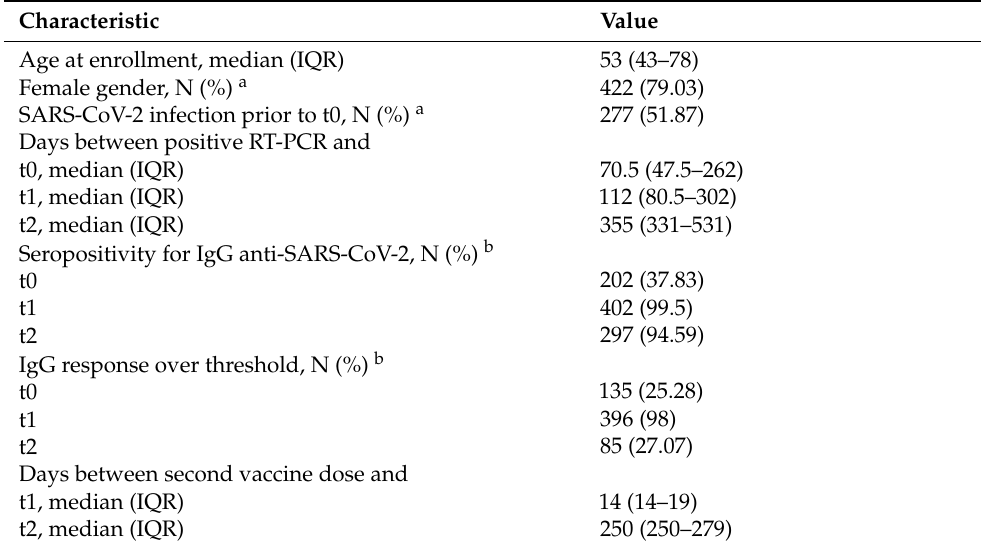
Table 1. Characteristics of healthcare workers (HCWs) and residents of 13 long-term care facilities participating in the study, Piedmont, Italy, 2021 (t0: N = 534, t1: N = 404, t2: N = 314).